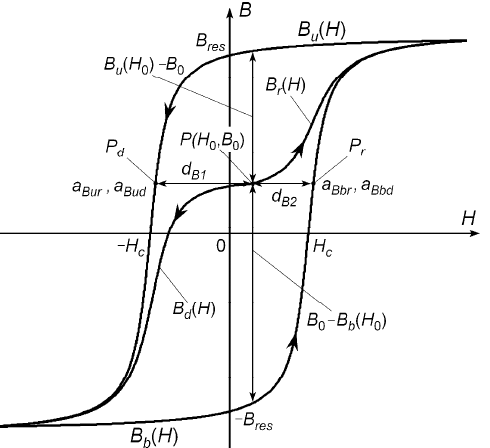
Figure 1. Typical hysteresis loop of electrical steel sheets; B res —residual flux density, H c —coercive field.